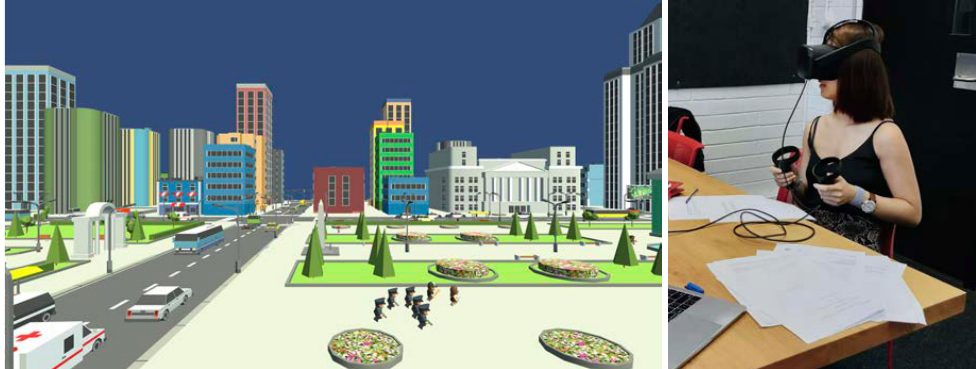
Figure 2. The simulated environment of the navigation study ( left ) and a participant using controllers for movement and interactions ( right